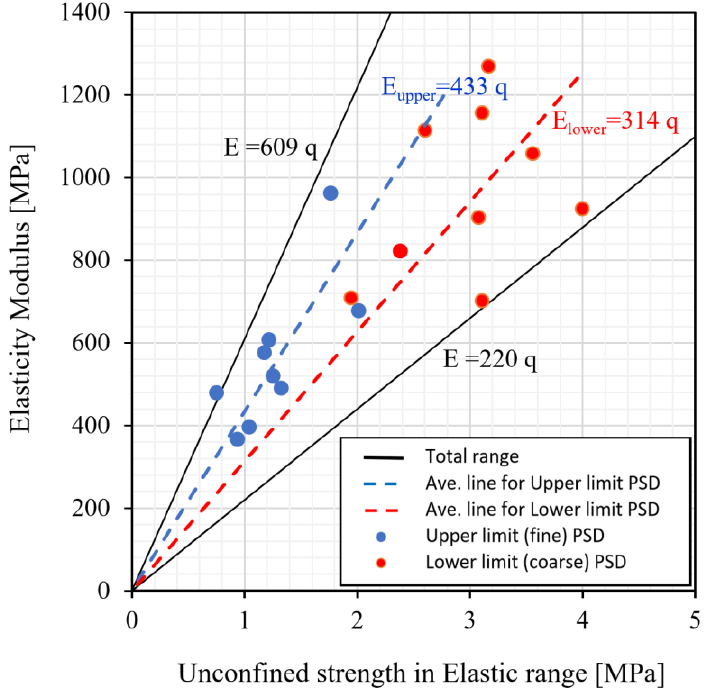
Figure 8. Relationship between unconfined compressive strength in elastic range and elastic modulus of